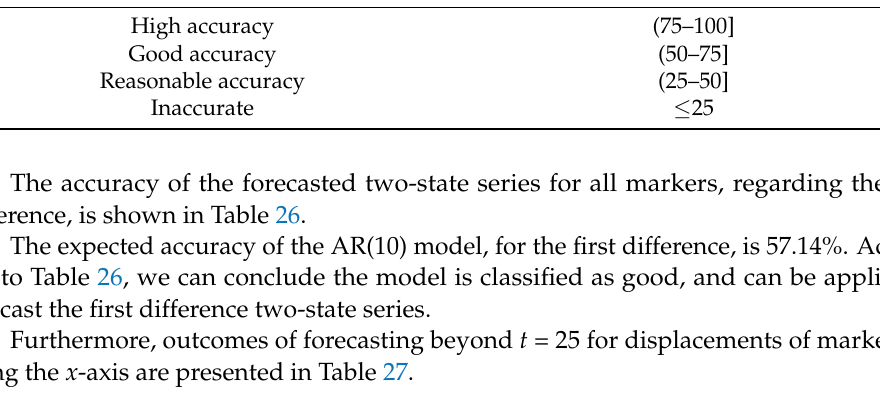
Table 25. Linguistic description of model accuracy for two-state series.